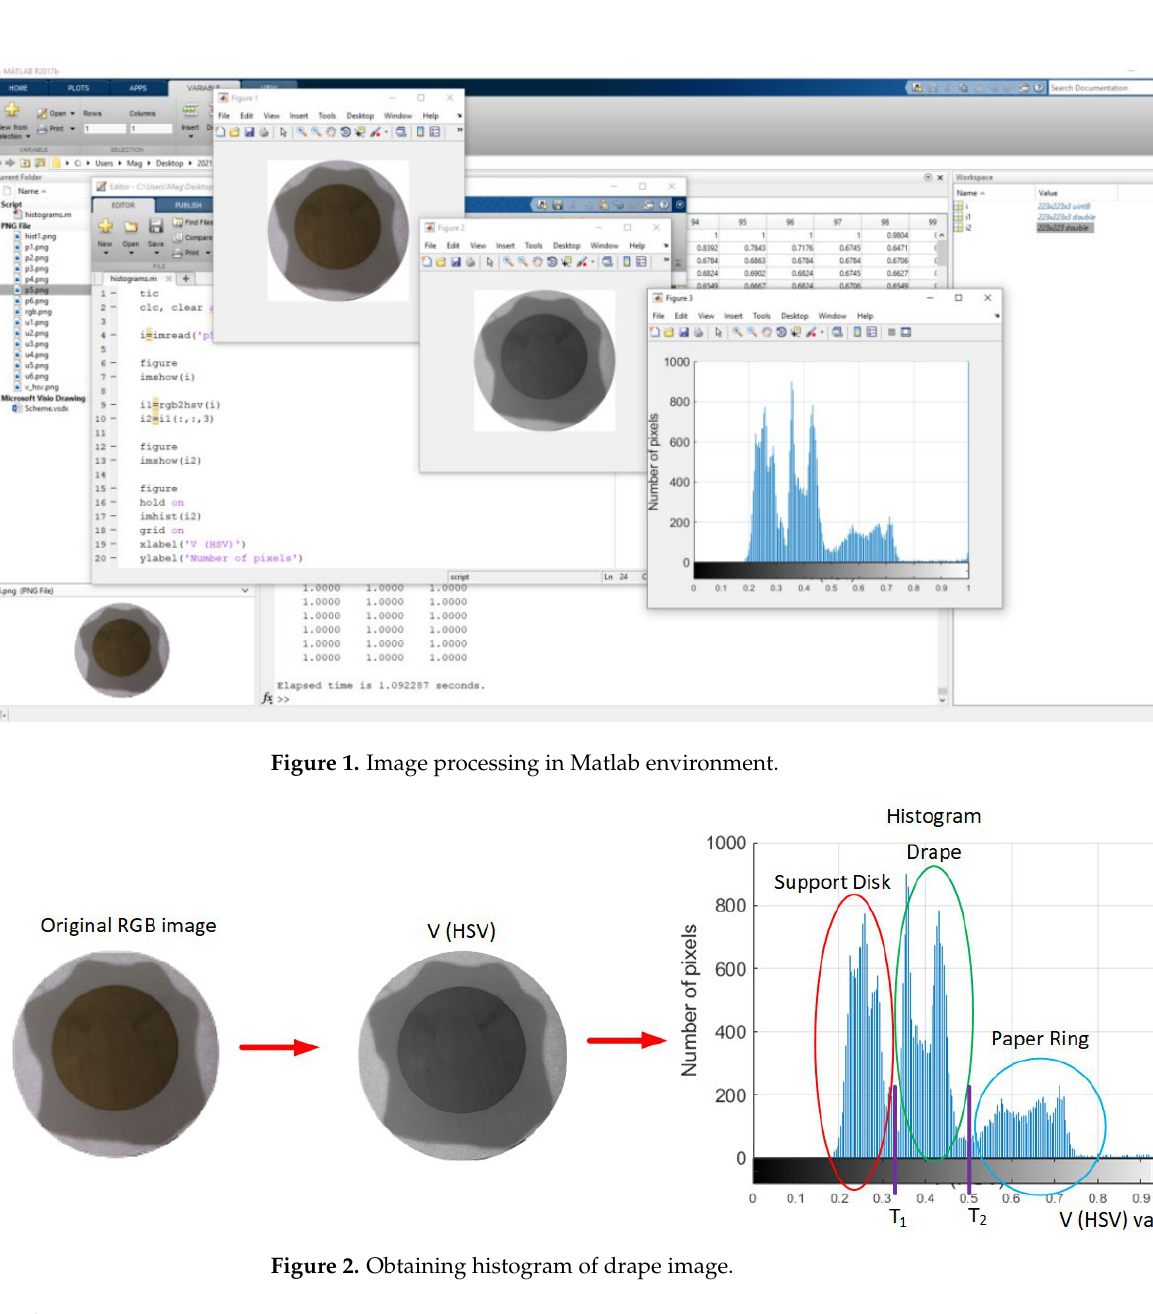
Figure 2. Obtaining histogram of drape image.